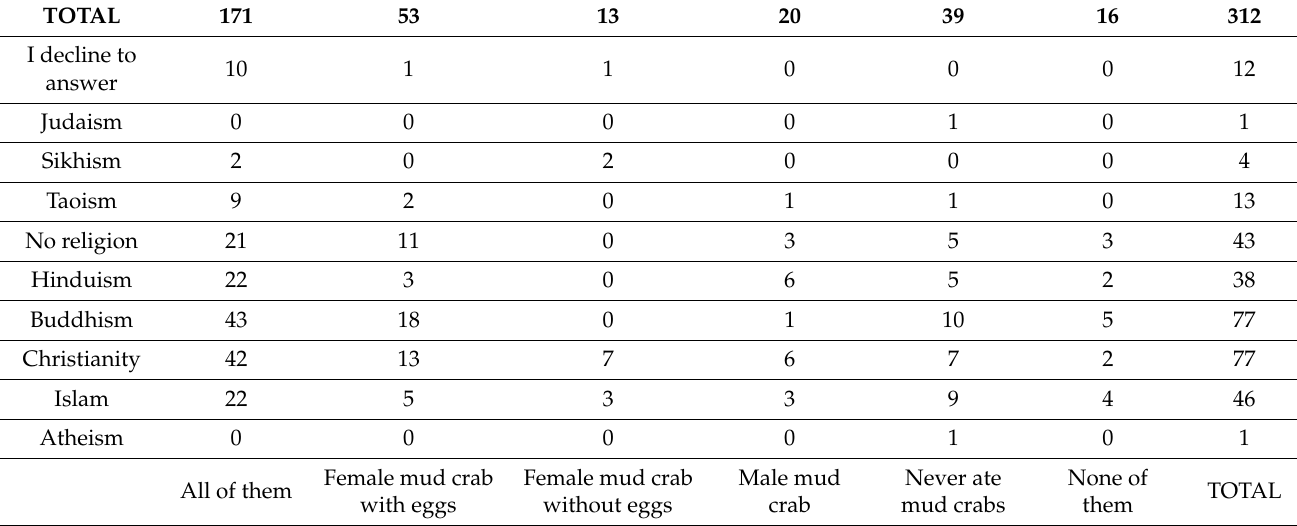
Table 5. Marginal cross table between religion and consumption of male or female mud